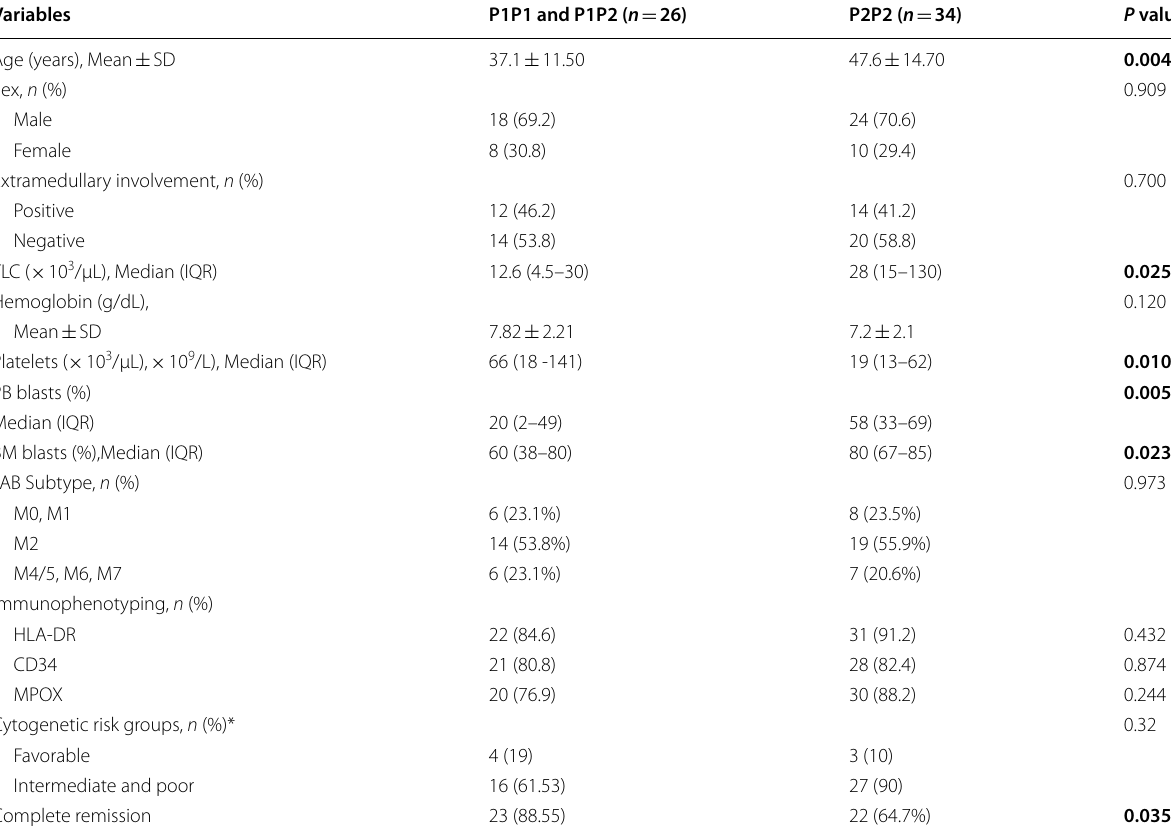
Bold values indicate significant p value *Six patients (23%) from (P1P2 P1P1) group and four patients (11.76%) from P2P2 group were excluded due to non -provided data or failed cytogenetic analysis + MPOX myeloperoxidase; Favorable cytogenetic markers: t(8;21), inv(16); Intermediate cytogenetic markers: normal karyotype, trisomy 8; Unfavorable cytogenetic markers t(11q23), t(9;11),